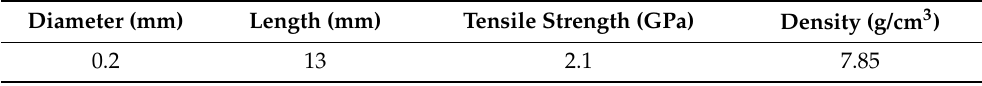
Table 2. Properties of straight copper-coated steel